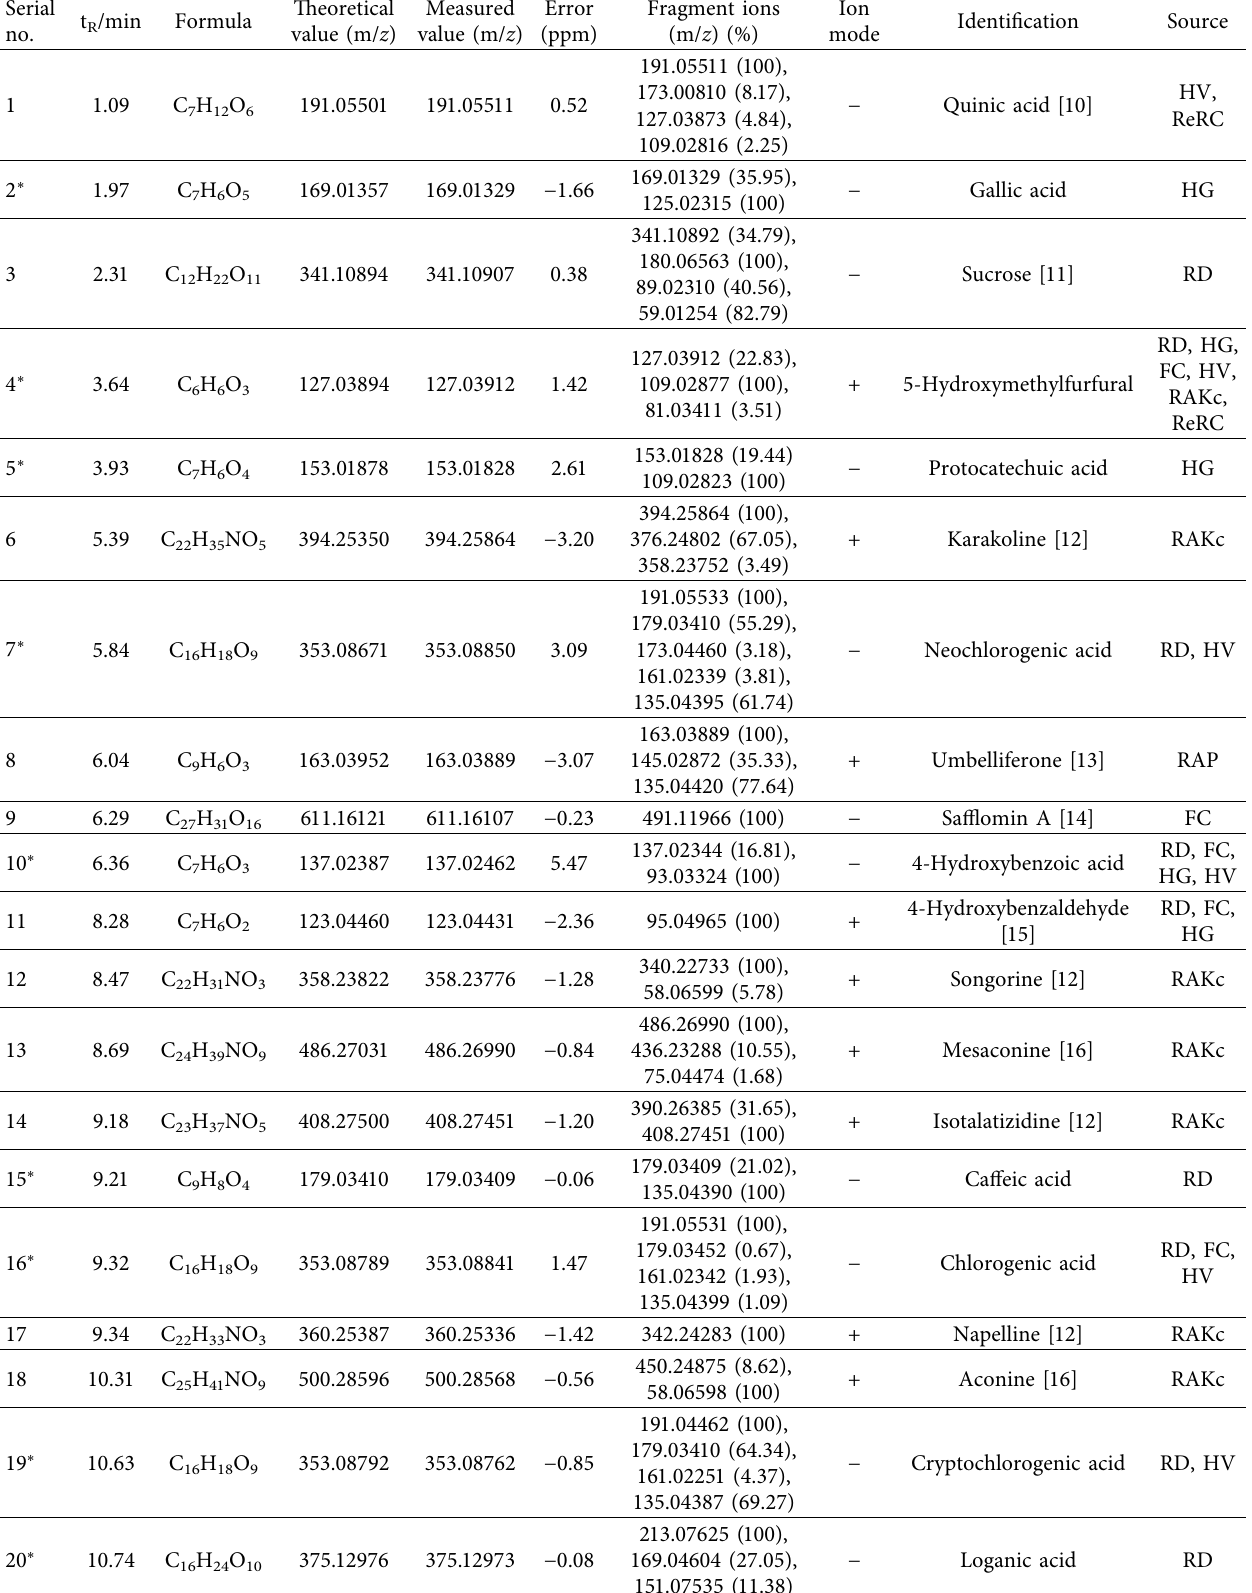
Table 1: Characterization of chemical constituents from Qufeng Zhitong capsule by UHPLC-Q Exactive Orbitrap MS. Serial